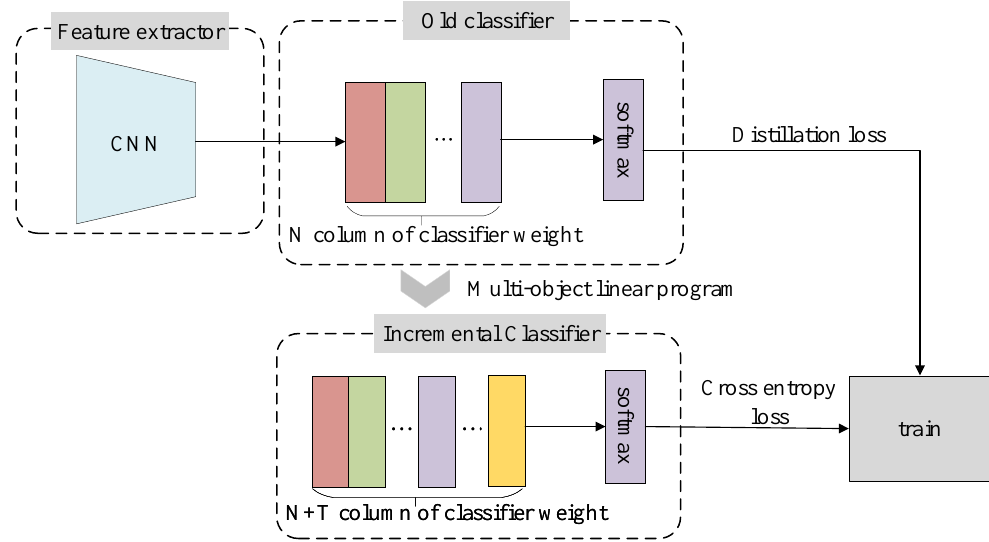
Figure 2. MOLP incremental classifier and training of the